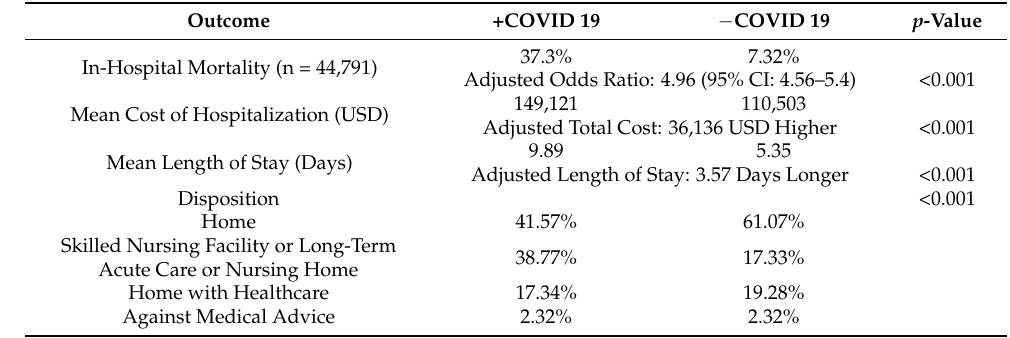
Table 2. NSTEMI Primary and Secondary Non-Procedural Outcomes Based on COVID-19 Status. Outcome